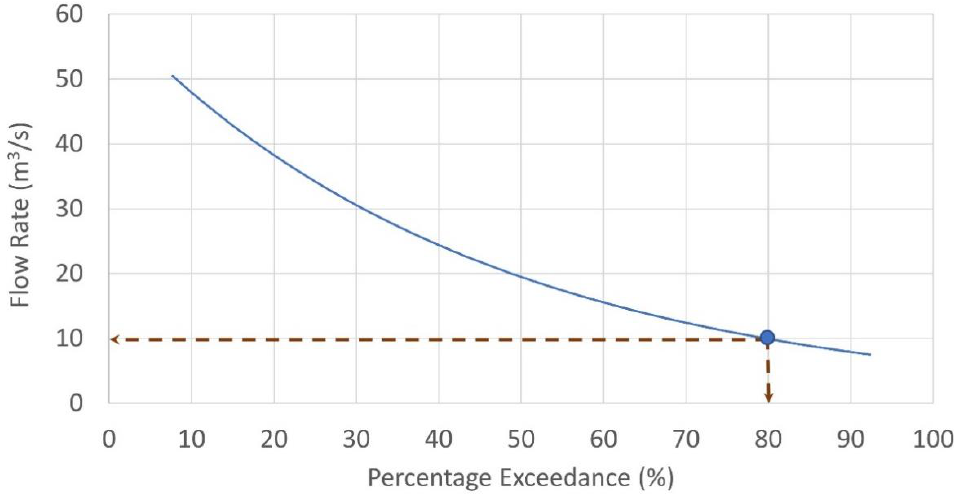
Figure 5. An example of a flow duration curve showing the equivalent flow of 10 m 3 /s at 80% flow exceedance.